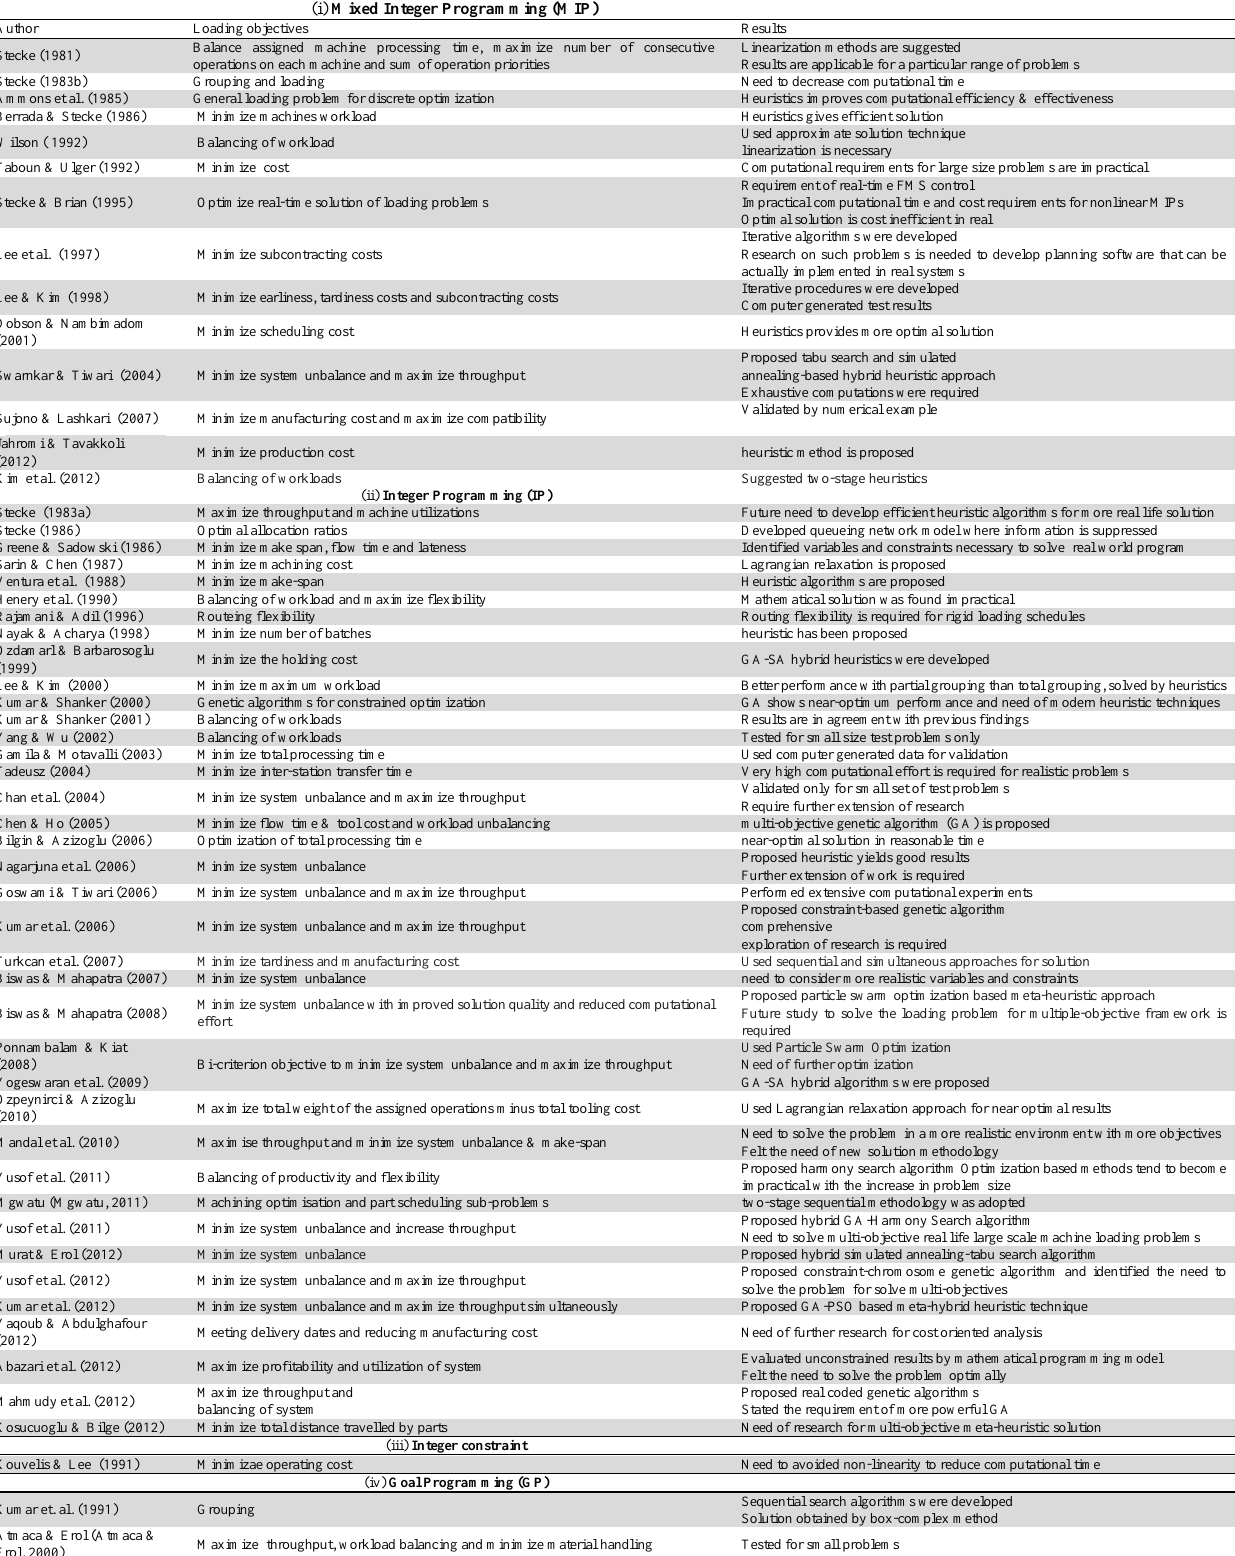
Table 1 Mathematical modelling of loading problem of FMS (i) Mixed Integer Programming (MIP) Author Loading objectives Results Stecke (1981) Balance assigned machine processing time, maximize number of consecutive operations on each machine and sum of operation priorities Linearization methods are suggested Results are applicable for a particular range of problems Stecke (1983b) Grouping and loading Need to decrease computational time Ammons et al. (1985) General loading problem for discrete optimization Minimize machines workload Heuristics gives efficient solution Balancing of workload